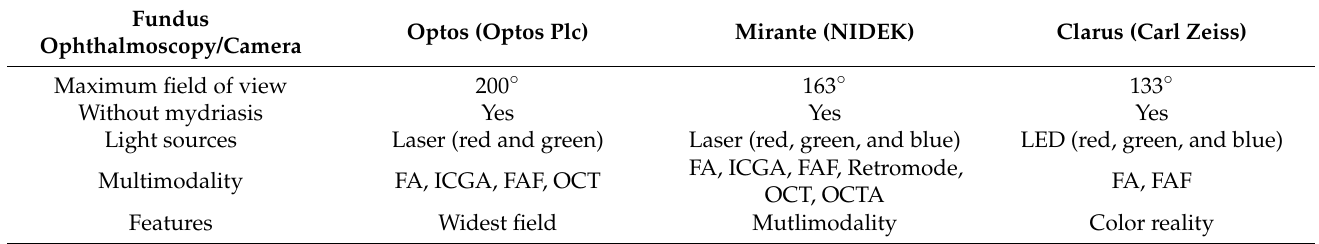
Table 1. Characteristics of ultra-widefield ophthalmoscopy.